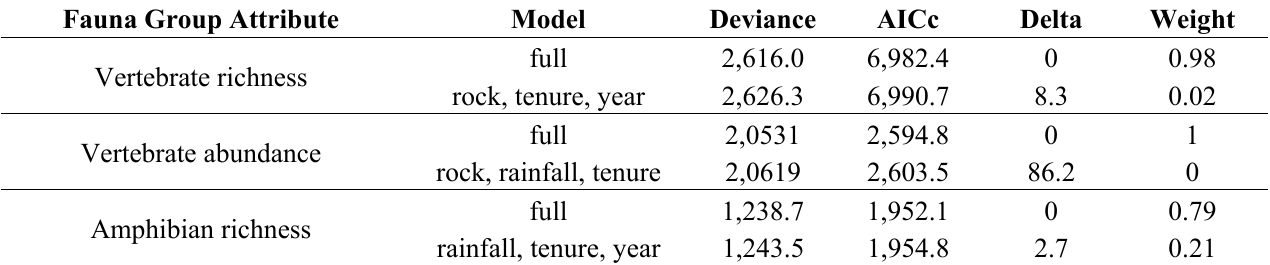
Table 1. Summary of model performance for vertebrate species richness and abundance. “Full” model includes all of the terms: rock cover, land tenure, year and